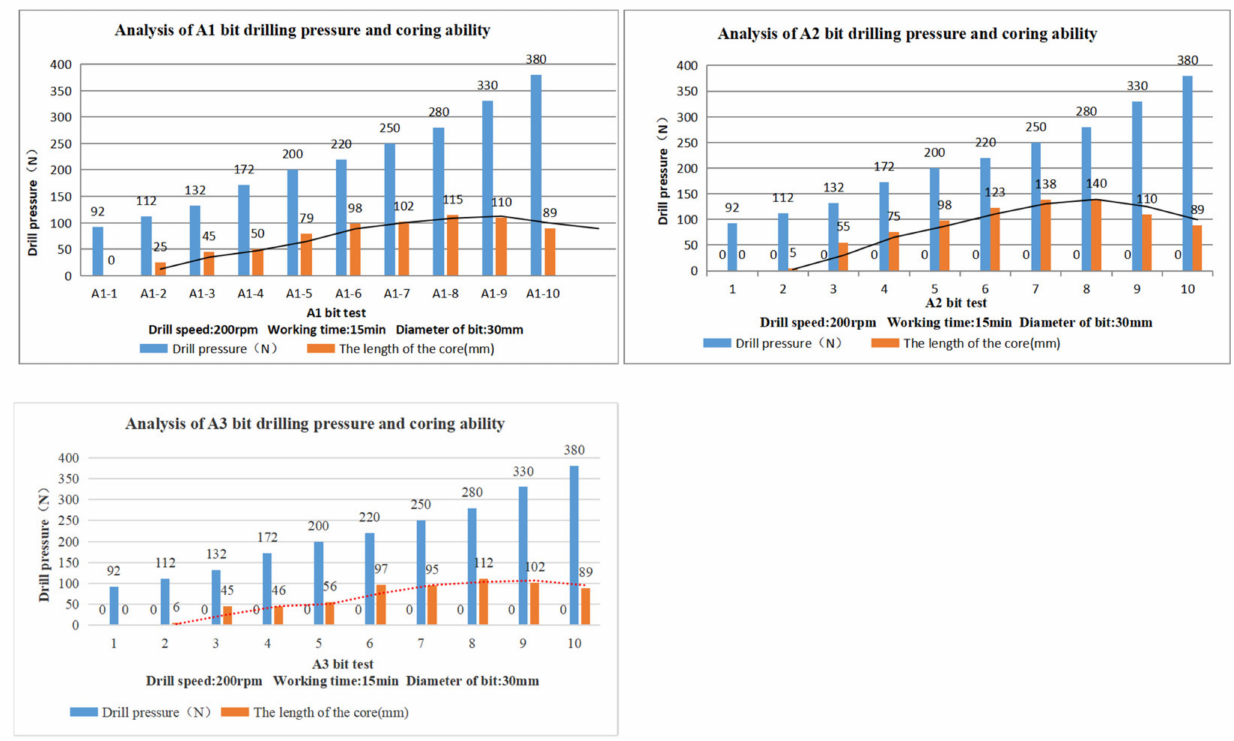
Figure 11. Coring tests on the three-bit types at certain speeds.